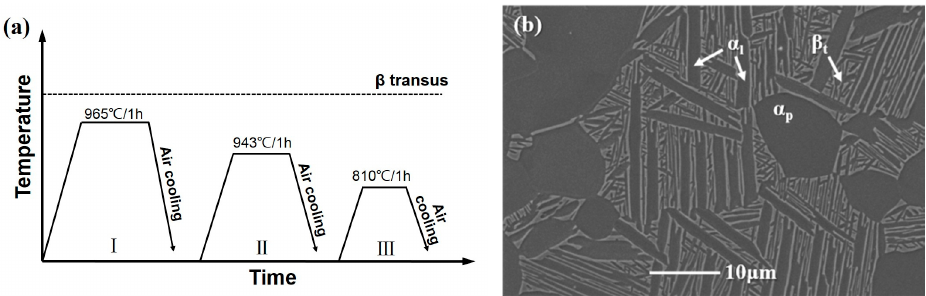
Figure 2. Processing schedule for obtaining tri-modal microstructure ( a ) and the obtained tri-modal microstructure ( b ).